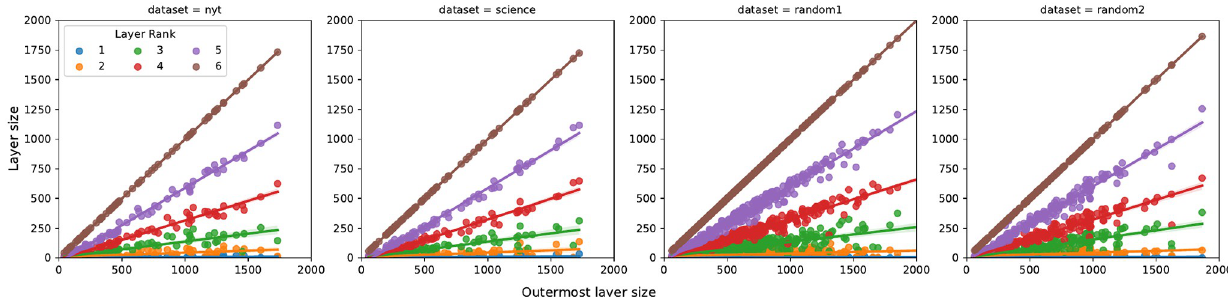
Fig 7. Size of external layer vs individual layer size: Linear regression plots. The x-axis corresponds to the total number of unique words used by each user (corresponding to the size of the outermost layer), the y-axis to the individual layer sizes.